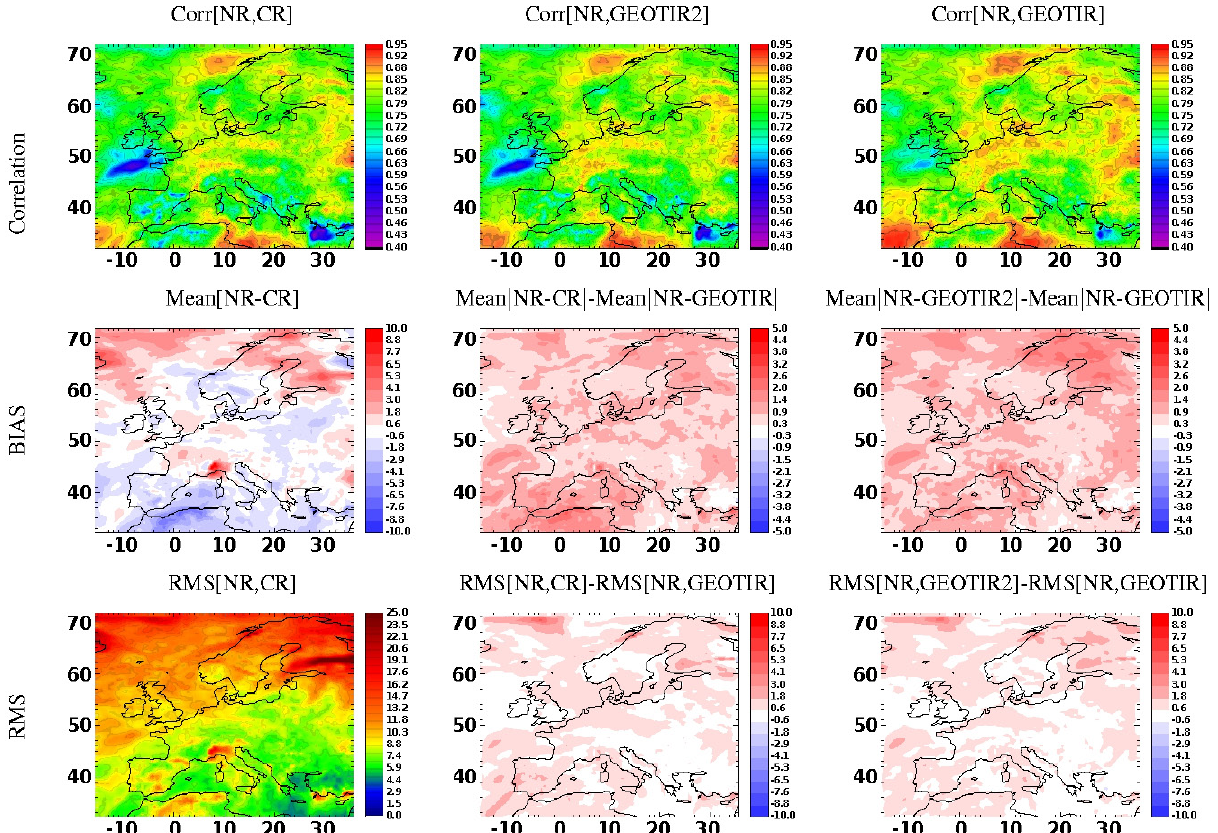
Fig. 5. Correlations (upper panel), absolute difference (middle panel) and root-mean square (lower panel) between the nature run (NR) and the control run (EXP1a) for the O 3 LmT column (1st column) for the experiment with a change in the meteorology (EXP1). For the 2nd and 3rd rows: (i) the 2nd column shows the difference between the nature run and the assimilation of GEO-TIR (EXP1c); and between the nature run and EXP1a; (ii) the 3rd column shows the difference between the nature run and EXP1c; and between the nature run and the assimilation of GEO-TIR2 (EXP1b). Red colours indicate that the assimilation of GEO-TIR improves the correlation (1st column) and reduces the absolute difference (2nd row) or the RMS (3rd row) whereas blue colours indicate a deterioration by using